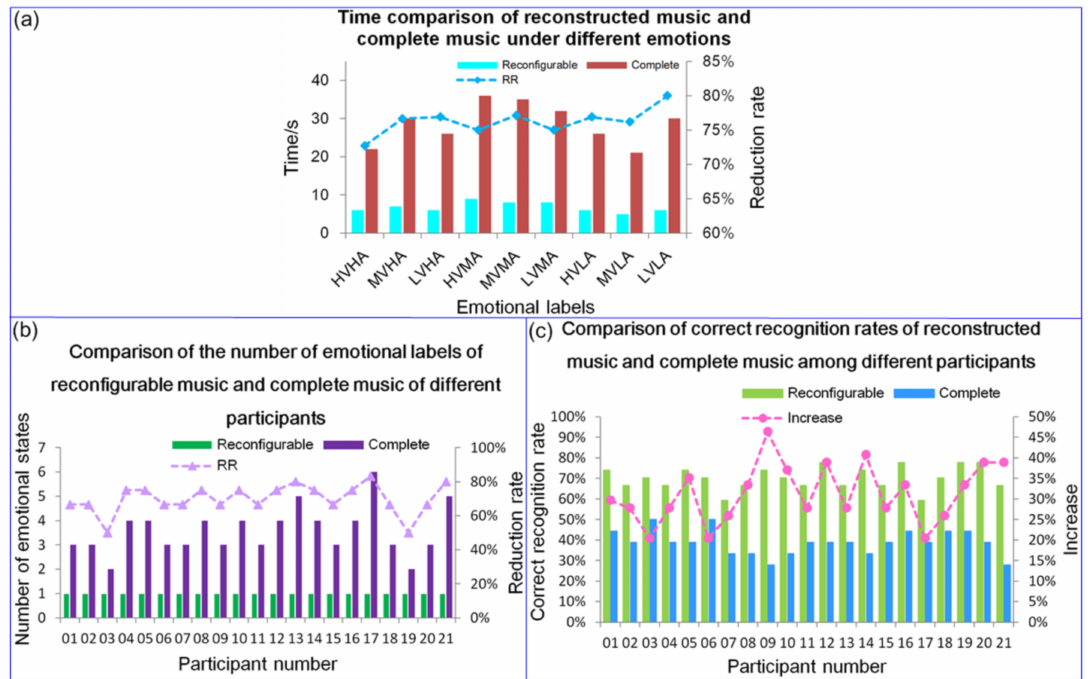
Figure 10. Contrast diagram of reconfigurable music and complete music: ( a ) a comparison chart of the duration of the two under different emotional labels; ( b ) comparison of the number of emotional states between reconstructed music and complete music for different participants; and ( c ) comparison diagram of the correct recognition rate of reconstructed music and complete music for different